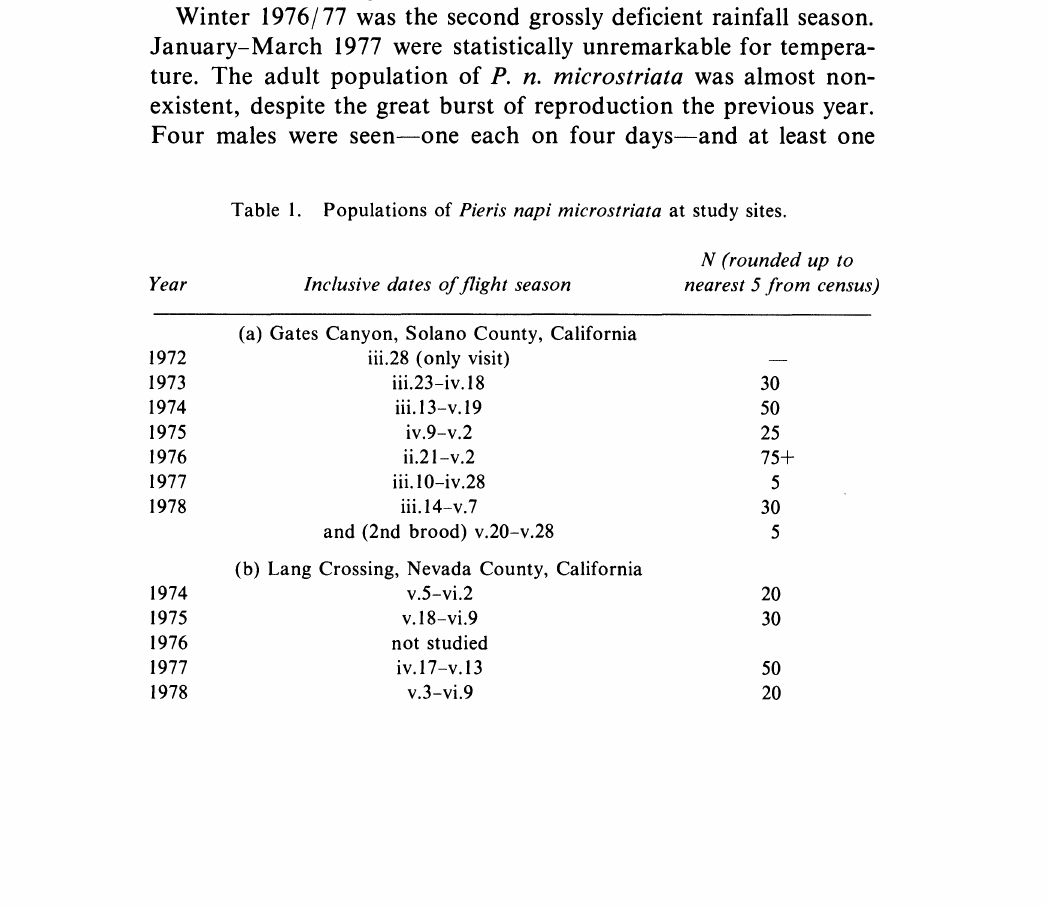
Table 1. Populations of Pieris napi microstriata at study sites. Inclusive dates of flight season